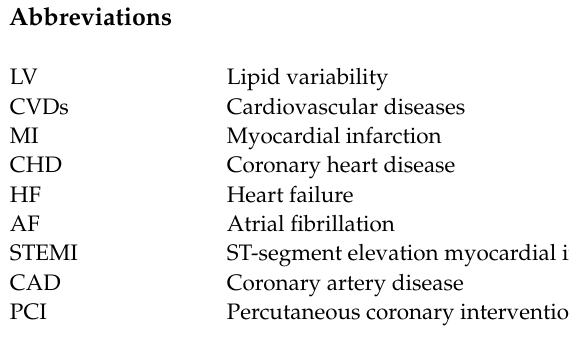
variability (top vs. bottom quartiles) with all-cause mortality; Figure S1: forest plots of standardized RRs for different types and metrics of TC variability (top vs. bottom quartile) with CVDs; Figure S2: forest plots of standardized RRs for different types and metrics of HDL-C variability (top vs. bottom quartile) with CVDs; Figure S3: forest plots of standardized RRs for different types and metrics of LDL-C variability (top vs. bottom quartile) with CVDs; Figure S4: forest plots of standardized RRs for different types and metrics of TG variability (top vs. bottom quartile) with CVDs; Figure S5: sensitivity analysis of standardized RRs for different types and metrics of LV (top vs. bottom quartile) and CVDs, excluding the articles counted on patients with hypertension or diabetes; Figure S6: forest plots of standardized RRs for different types and metrics of TC variability (top vs. bottom quartile) and all-cause mortality; Figure S7: forest plots of standardized RRs for different types and metrics of HDL-C variability (top vs. bottom quartile) and all-cause mortality; Figure S8: sensitivity analysis of standardized RRs for different types and metrics of LV (top vs. bottom quartile) and all-cause mortality, excluding the articles counted on patients with hypertension or diabetes; Figure S9: funnel plots of standardized RRs for different types and metrics of TC variability (top vs. bottom quartile) and CVDs; Figure S10: funnel plots of standardized RRs for different types and metrics of HDL-C variability (top vs. bottom quartile) and CVDs; Figure S11: funnel plots of standardized RRs for different types and metrics of LDL-C variability (top vs. bottom quartile) and CVDs; Figure S12: funnel plots of standardized RRs for different types and metrics of TG variability (top vs. bottom quartile) and CVDs; Figure S13: funnel plots of standardized RRs for different types and metrics of TC variability (top vs. bottom quartile) and all-cause